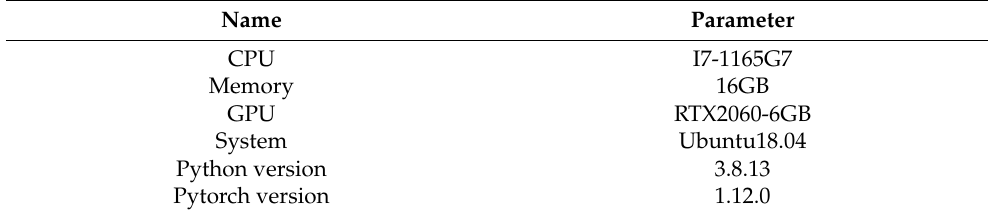
Table 1. Hardware and software parameters of industrial